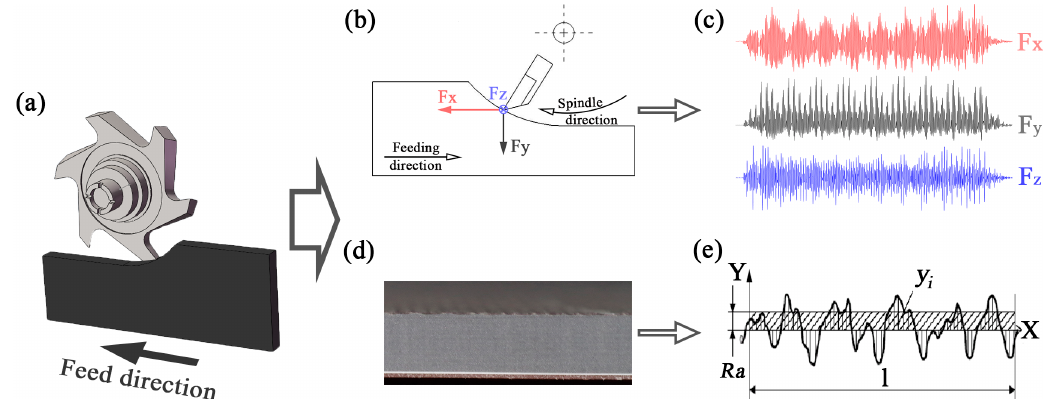
Figure 1. Milling experiment: ( a ) Helical milling; ( b ) measurement of cutting forces; ( c ) waveform of cutting forces; ( d ) machined surface of Luxury vinyl tile (LVT); ( e ) surface roughness. Table 1. Material properties of LVT.